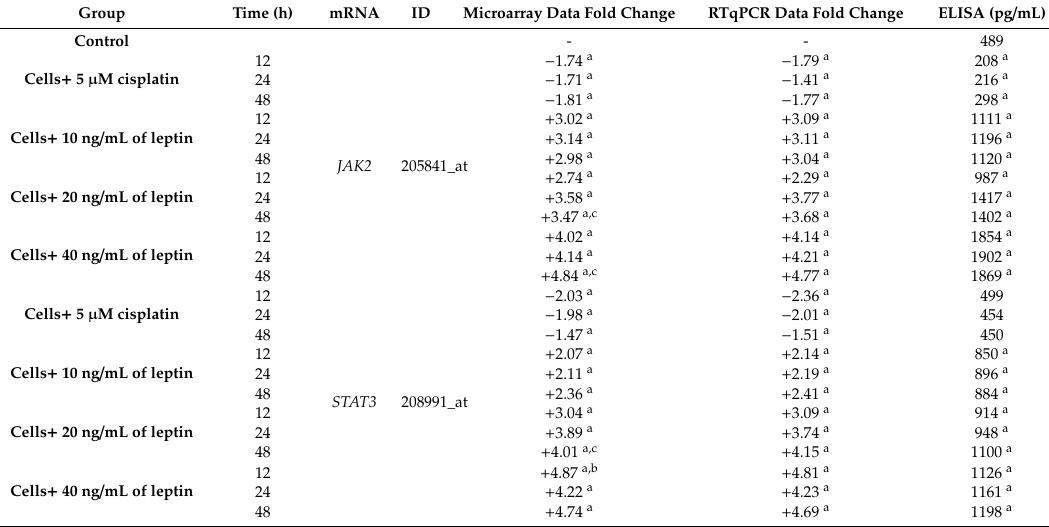
Table 3. Di ff erences in the expression of mRNA JAK2 and STAT3 and protein in endometrial cancer cells treated with cisplatin and leptin in comparison with the control culture.